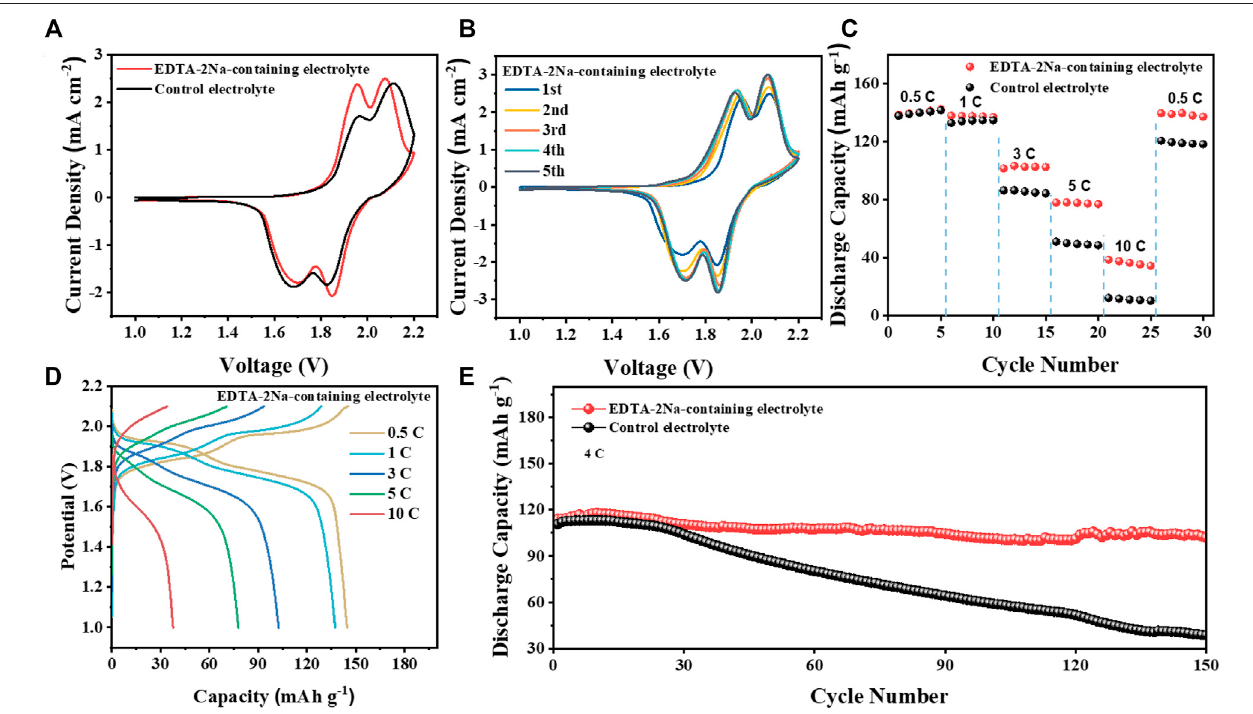
FIGURE 5 | Electrochemical performance of Zn||LiMnO 4 cells. (A) CV of Zn (cid:2) LiMnO4 full cells with different electrolytes at a scan rate of 0.5 mV s − 1 . (B) CV of Zn|| LiMnO 4 full cells with EDTA-2Na-containing electrolyte for fi ve cycles. (C) Rate capability for Zn (cid:2) LiMnO 4 full cells. (D) Rate performance in EDTA-2Na-containing electrolyte. (E) Cyclic stability and ef fi ciency of Zn||LiMnO 4 cells in two electrolytes at 4